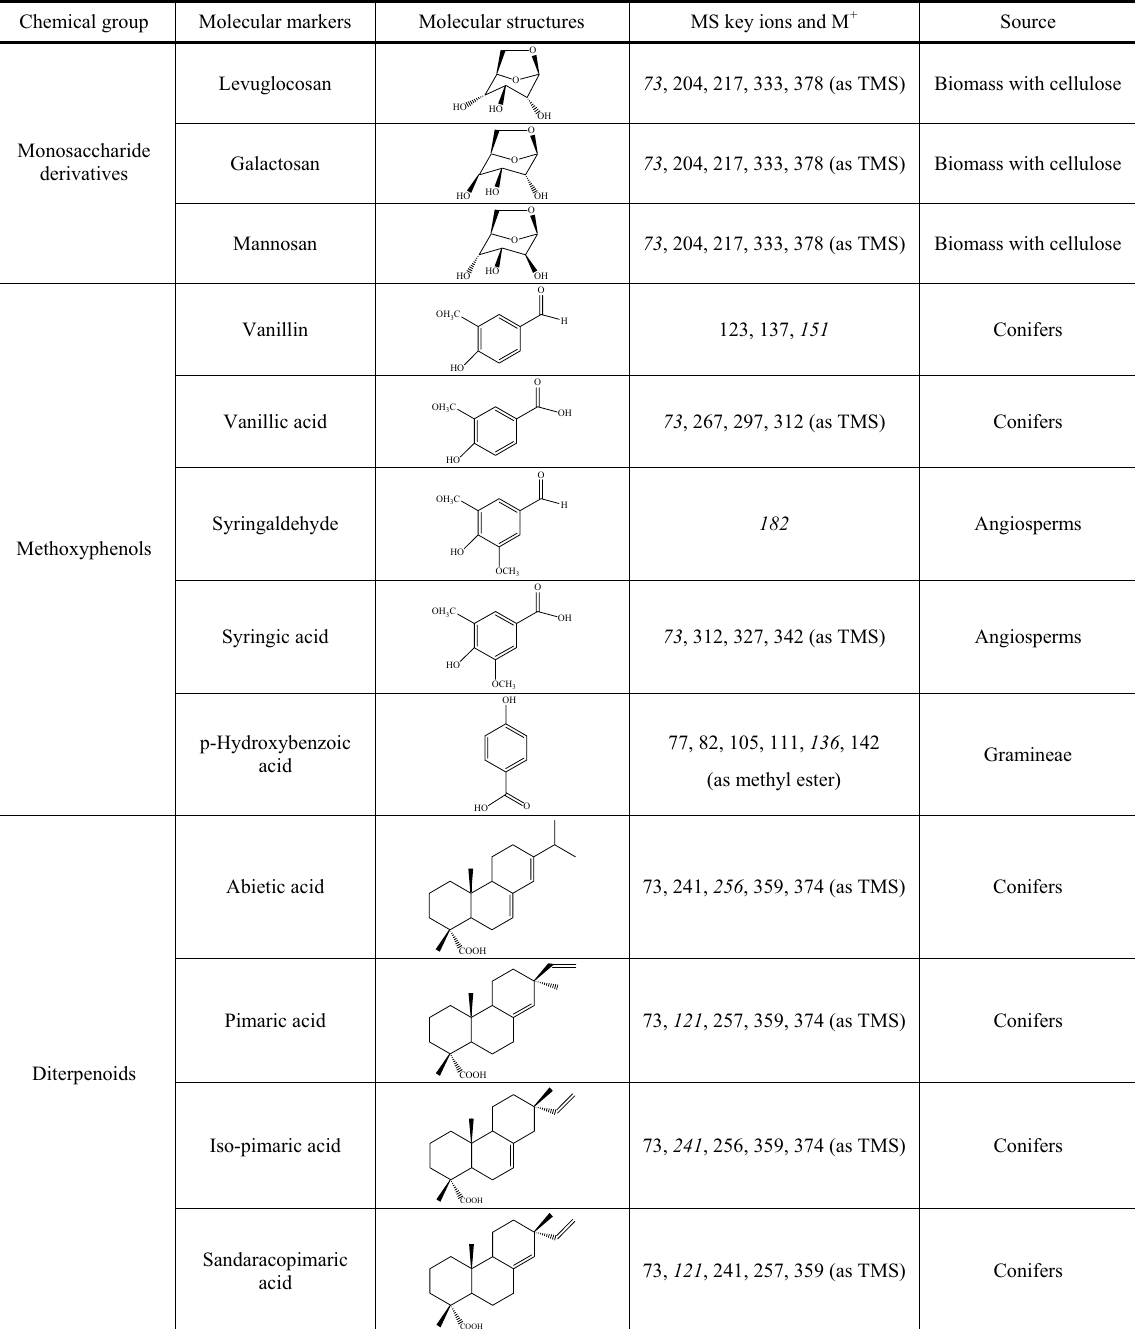
Molecular tracers for biomass burning